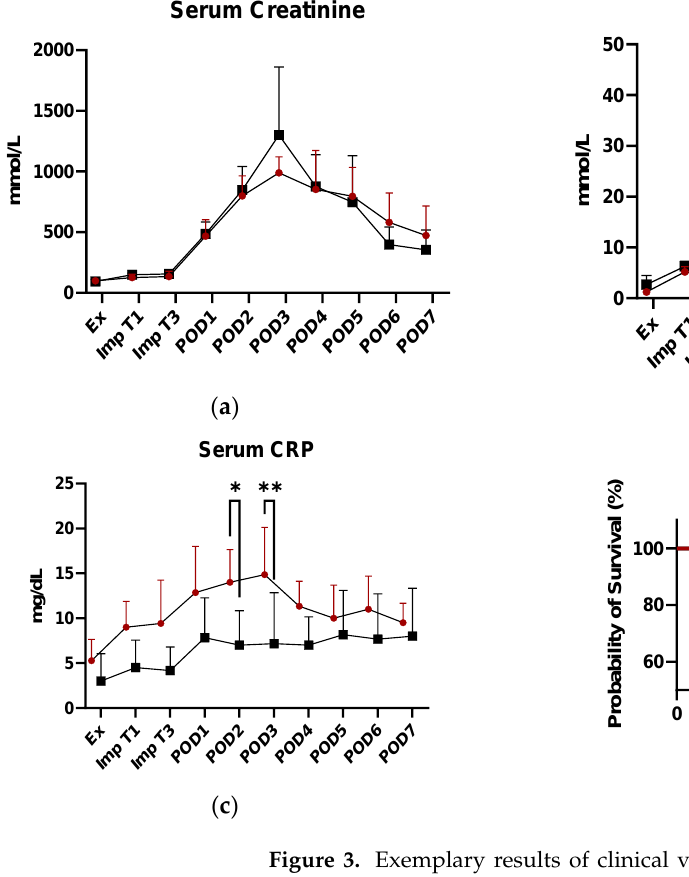
Figure 3. Exemplary results of clinical values and survival for 7 days post operatively = POD. ( a ) Creatinine serum levels ( b ) Urea serum levels ( c ) CRP Serum levels ( d ) Animal survival. * p < 0.05, ** p > 0.01 2-Way ANOVA Sidak’s multiple comparison.